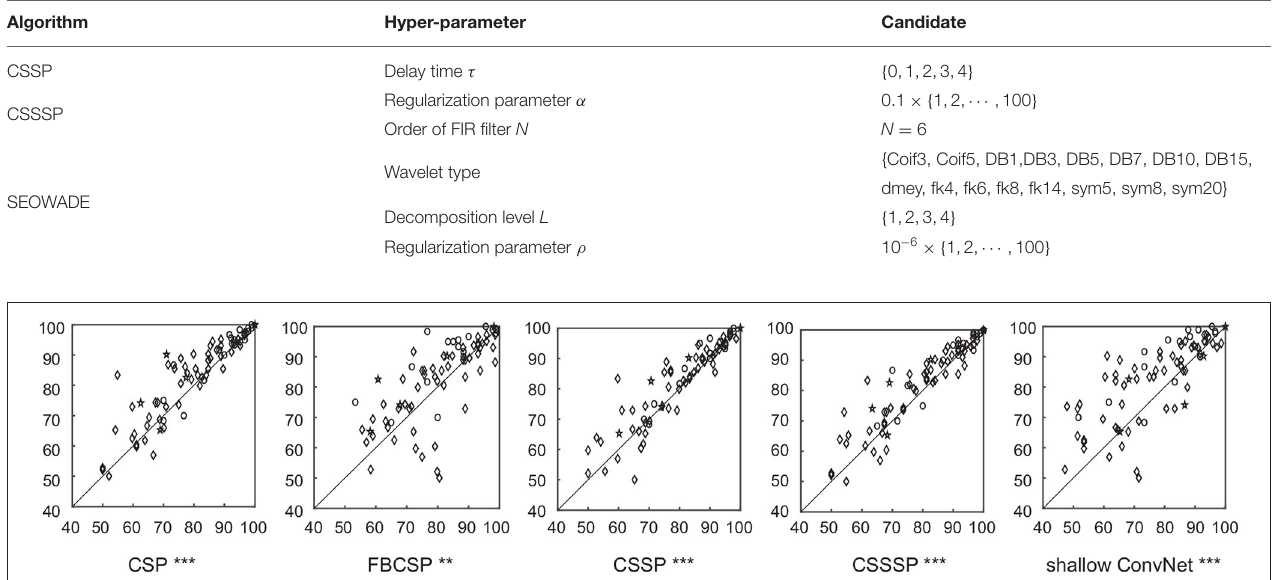
TABLE 3 | Mean classification accuracies and standard deviation (%) of CSP, FBCSP, CSSP, CSSSP, shallow ConvNets and SEOWADE on the three data sets (the numbers of subjects are M 5,18,54, respectively), with RVM (with Gaussian prior) is implemented as the classifier. =